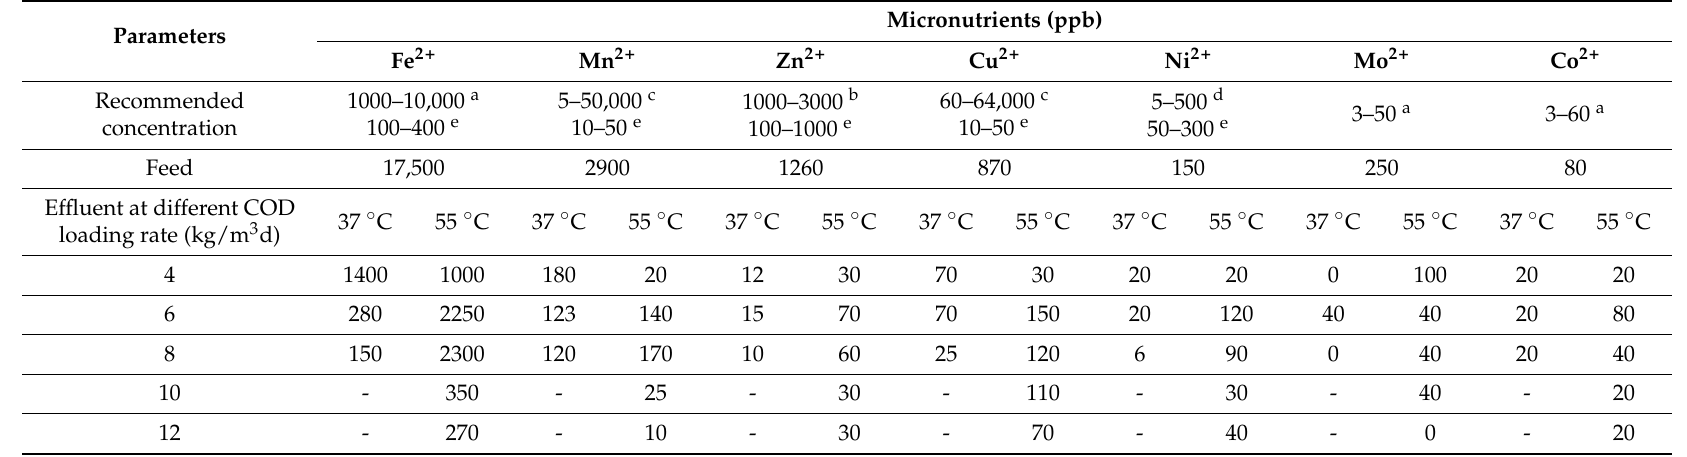
Table 3. Concentration of micronutrients in the ASBR system operated at a mesophilic or thermophilic temperature at different COD loading rates, as compared with the recommended values for AD (with S.D. less than